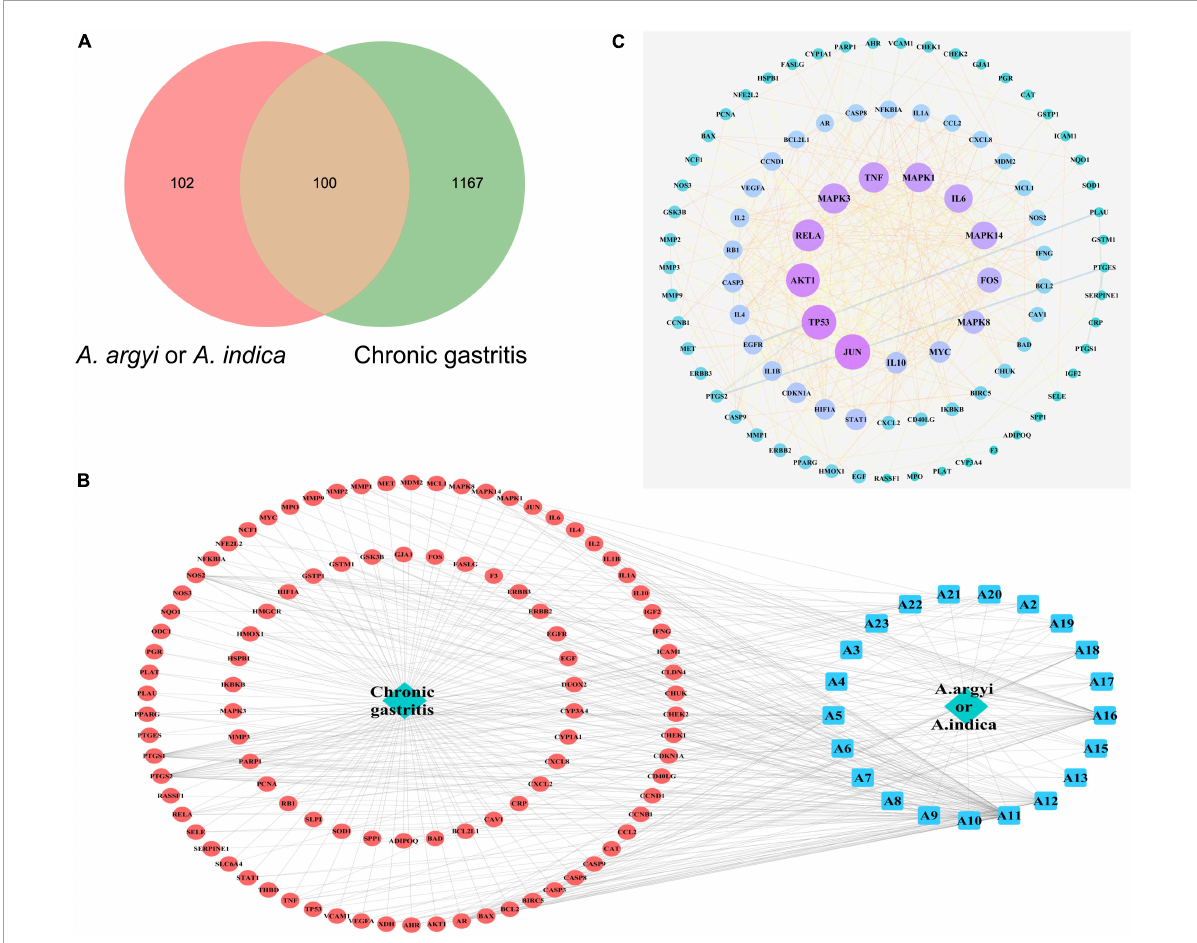
FIGURE7 Diagram of interactions between drug targets and disease targets. (A) Venn diagram of the intersection of target genes of A. argyi and A. indica and chronic gastritis (CG)-related genes. (B) Topological network of CG target genes of A. argyi and A. indica . (C) Network map of A. argyi and A. indica -compound-drug action target-disease. The larger node represents the higher